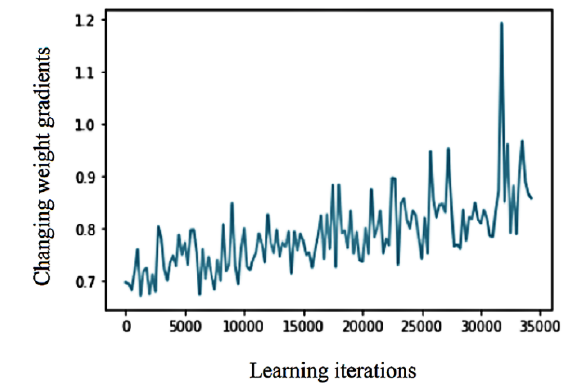
Fig. 5. Graph of changes in the gradients of weights of the first layer of an artificial neural network .